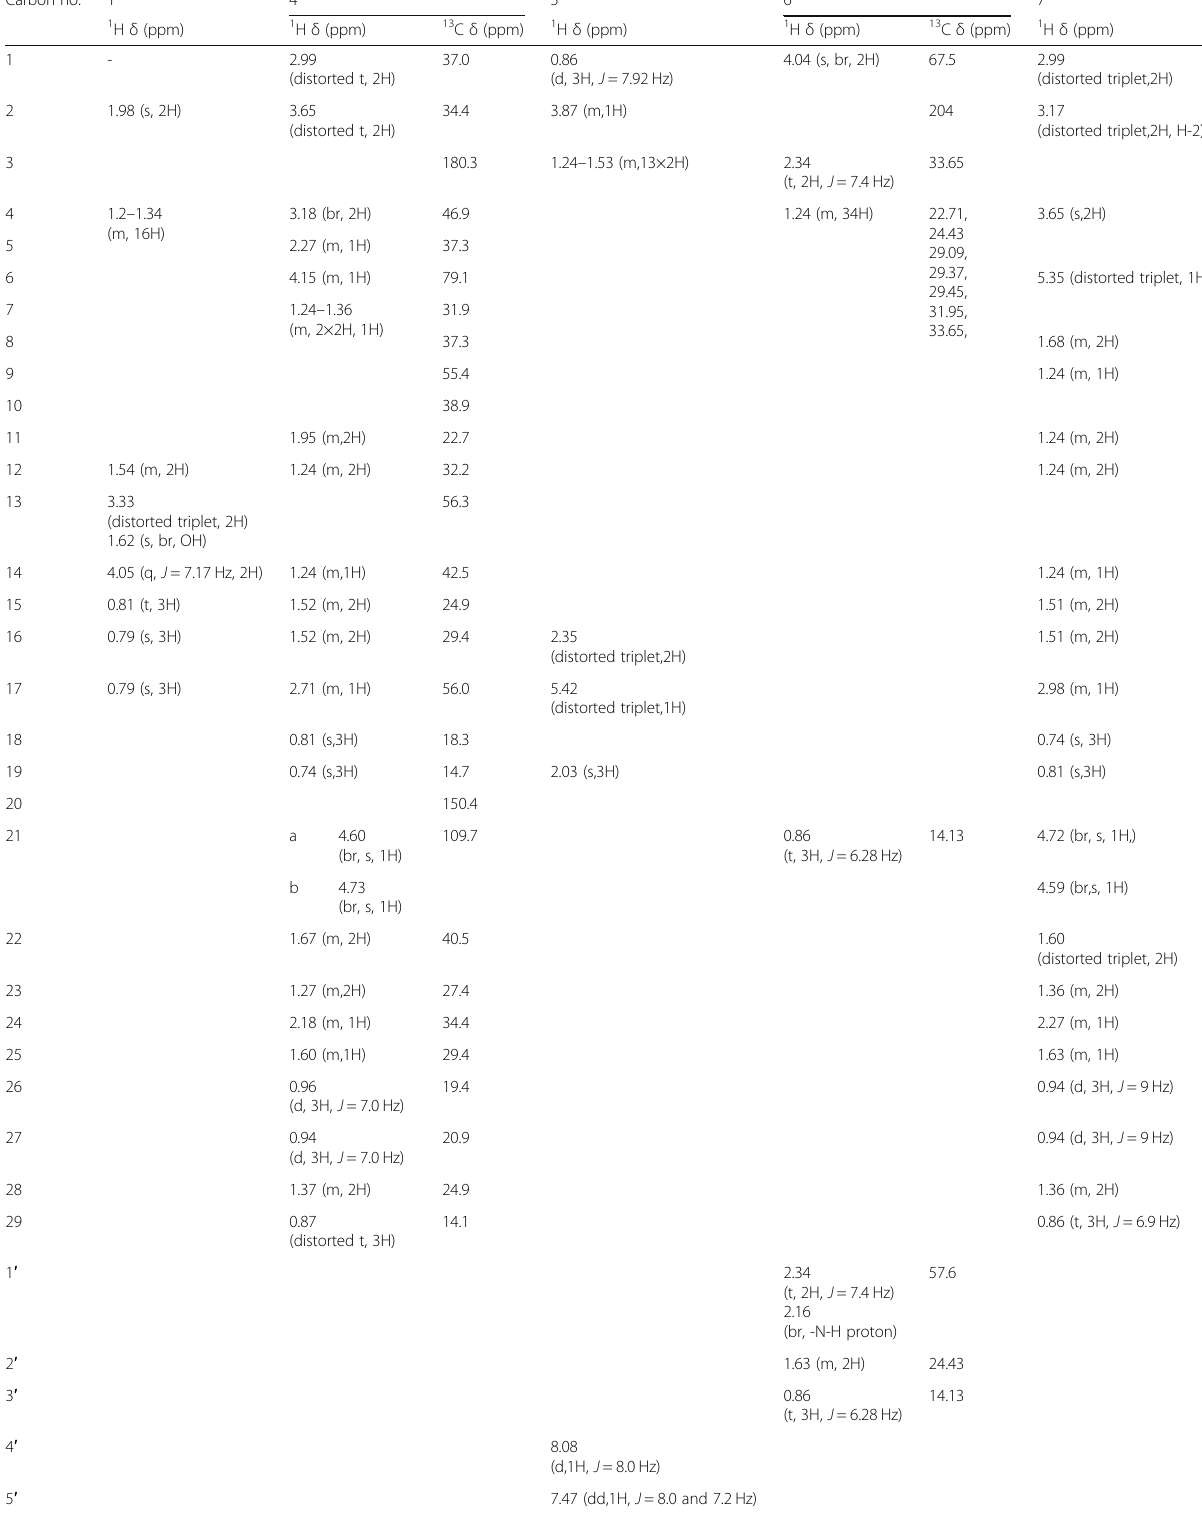
Table 1 1 H and 13 C NMR δ (ppm) data of compounds 1, 4 – 7 Carbon